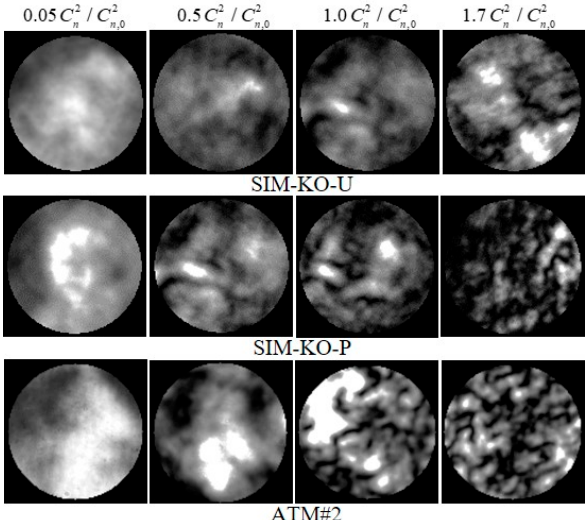
Figure 11. Examples of selected intensity scintillation images from SIM-KO-U ( top row ), SIM-KO-P and ATM#2 ( bottom row ) datasets corresponding to different turbulence strength as indicated by C 2 n values above each column.